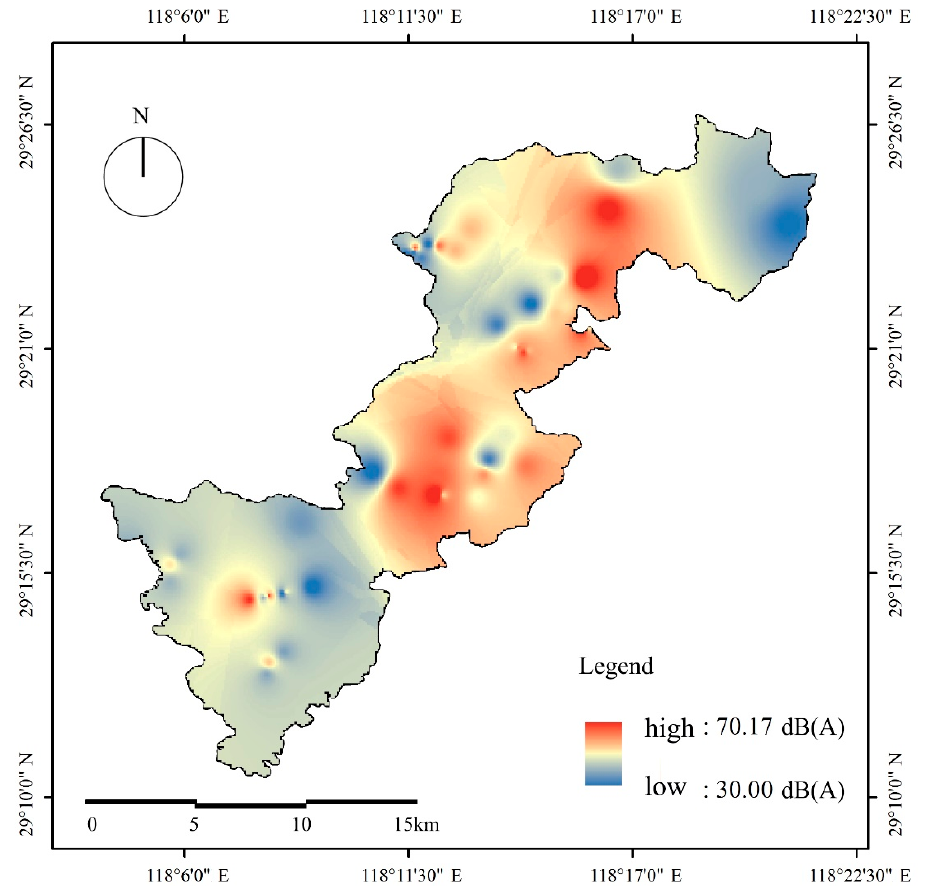
Figure 2. The spatial distribution of sound levels in the soundscape of the system pilot area.